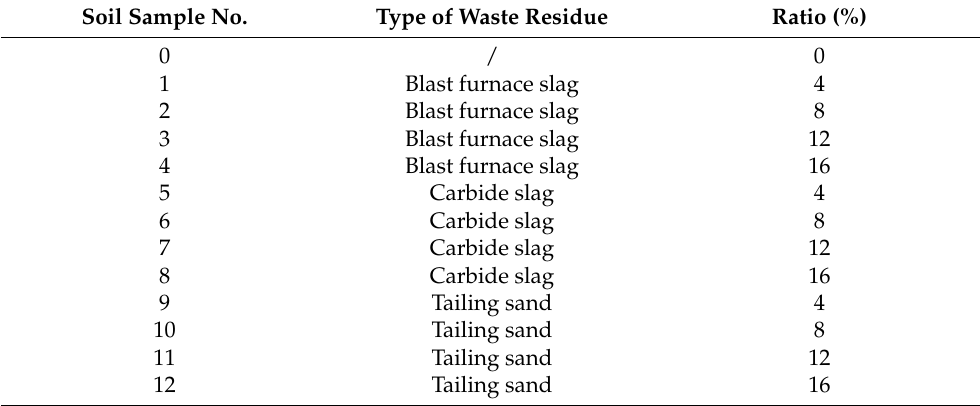
Table 3. Soil improvement test conditions of different industrial waste residues with different ratios. Soil Sample No.